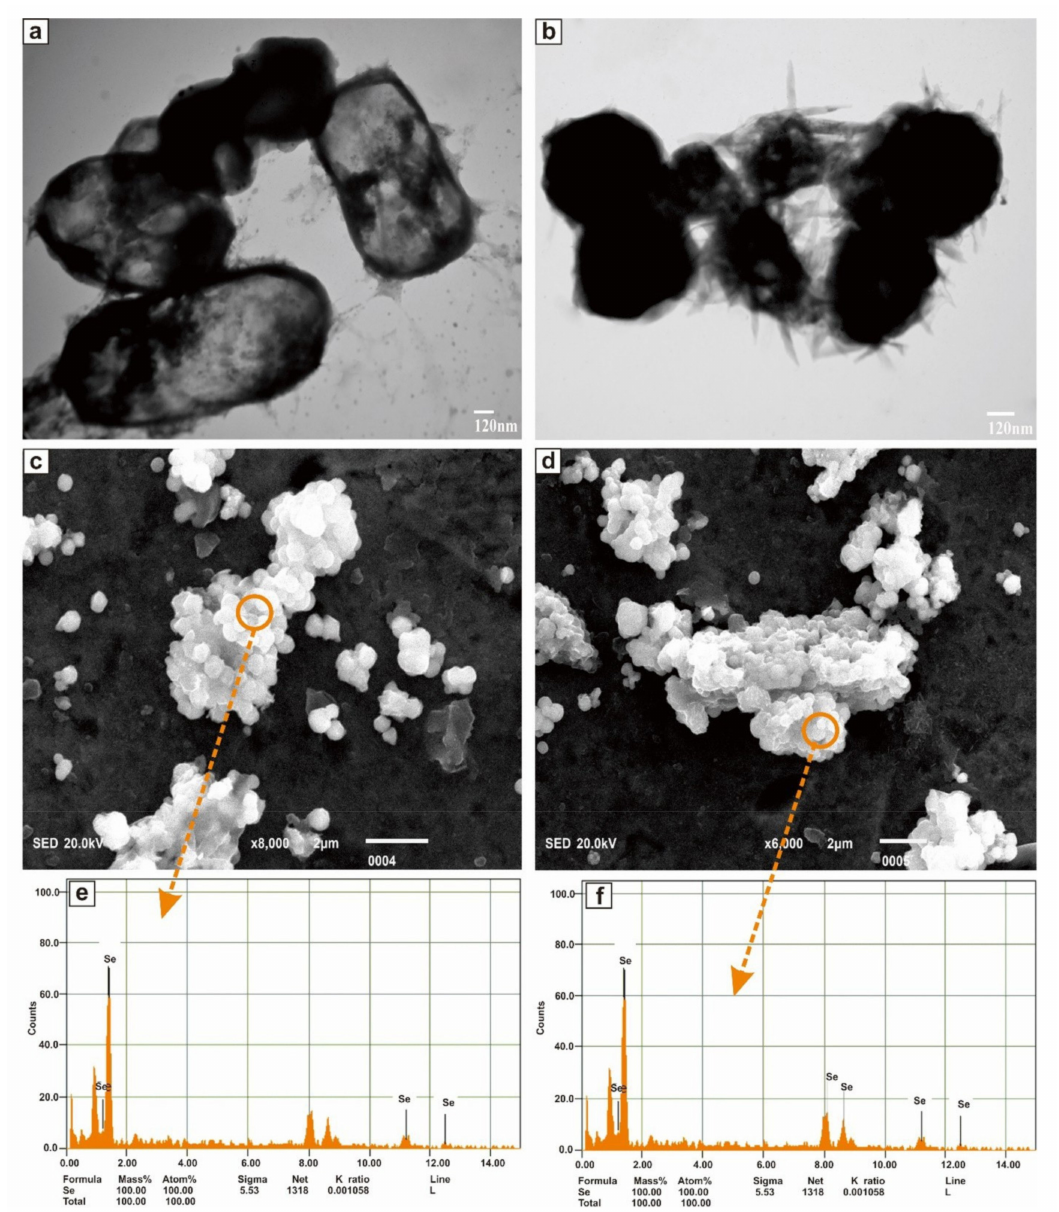
Figure 6. TEM images ( a , b ), SEM images ( c , d ), and EDS spectra ( e , f ) of purified SeNPs produced by BSN313 during 24